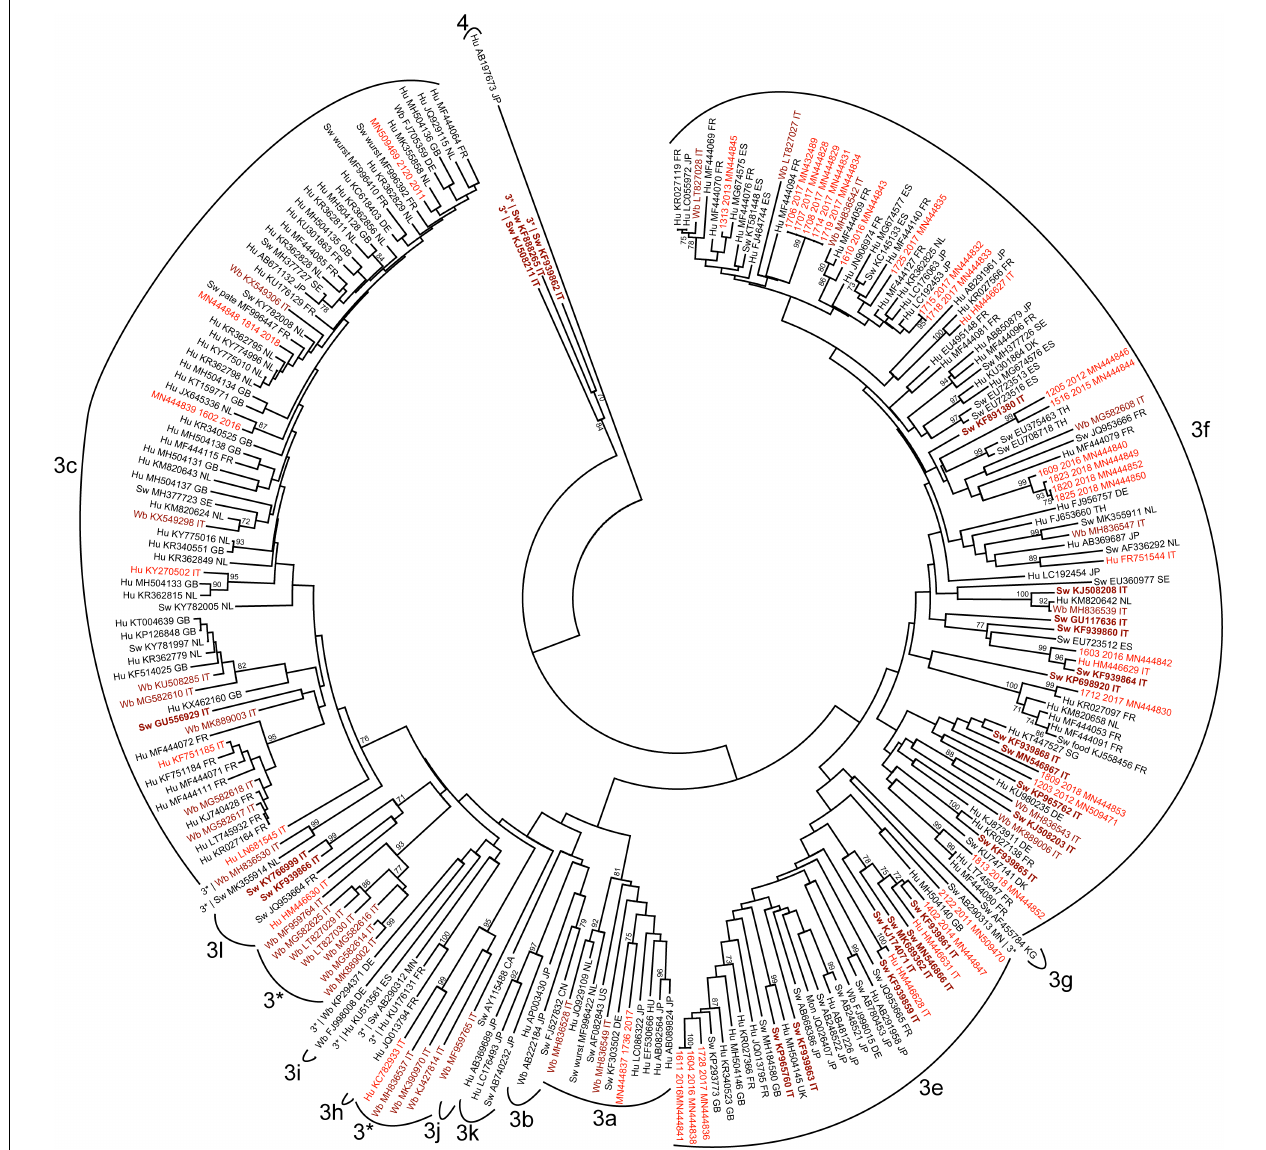
FIGURE 2 | Phylogenetic analysis based on the 300 nt fragment of the partial ORF2 region of HEV-3 strains derived of human or animal origin. A total of 244 HEV-3 sequences have been included, and the HEV-4 sequence (Hu AB197763JP) was used as outgroup. The maximum likelihood tree was produced using the Tamura–Nei parameter model based on 1,000 bootstrap replications and bootstraps values > 70 are indicated at their respective nodes. Each entry includes host (Hu, human; Sw, swine; Wb, wild boar; Mon, monkey), accession number and countries origin of strains. The human Italian strains from this study were reported by sequence name and accession number. Italian sequences are highlighted as follows: human sequences are in red, animal sequences (swine and wild boar) are in brown, of which swine sequences are in bold.